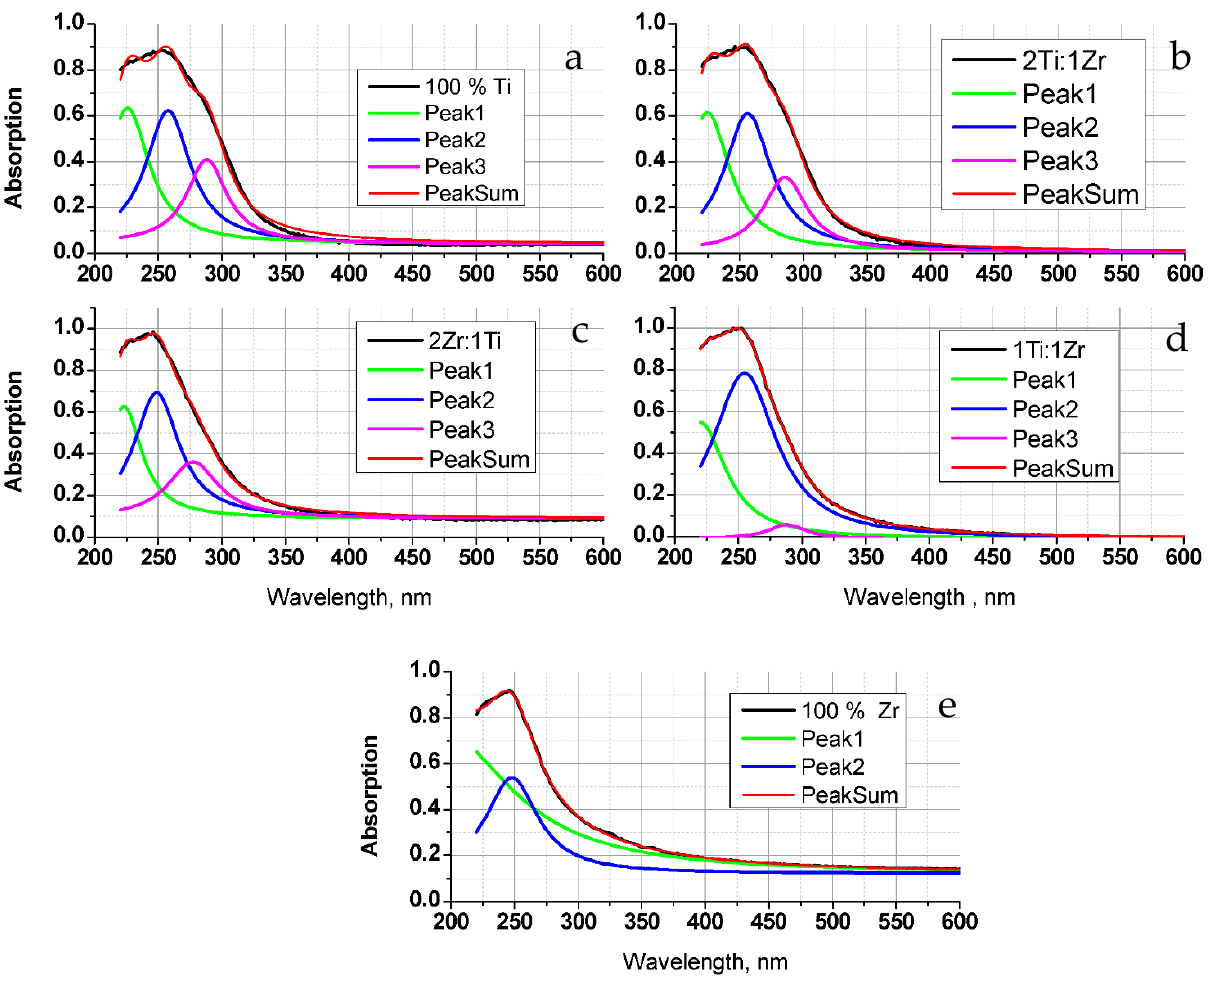
Figure 4. Deconvolution graphs of diffuse reflectance spectra: ( a ) 100% Ti; ( b ) 2Ti:1Zr; ( c ) 2Zr:1Ti; ( d ) 1Ti:1Zr; ( e ) 100%Zr.